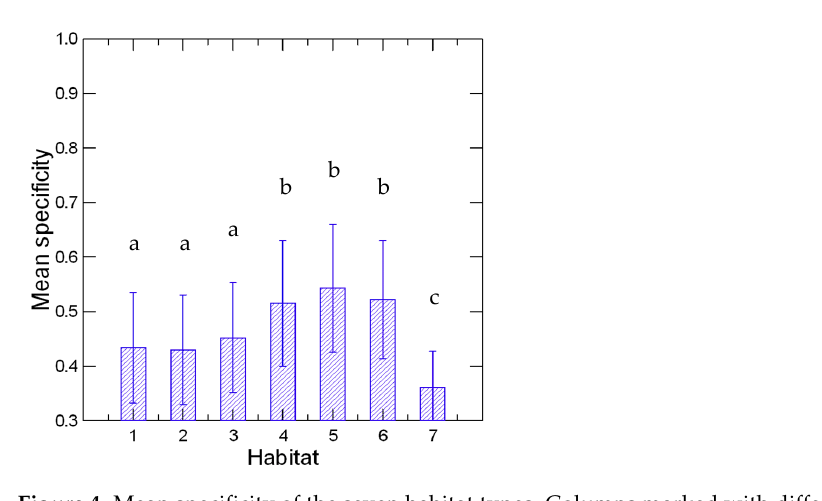
Figure 4 . Mean specificity of the seven habitat types. Columns marked with different letters denote specificities that are significantly different ( p < 0.05). Error bars are 1 sem.